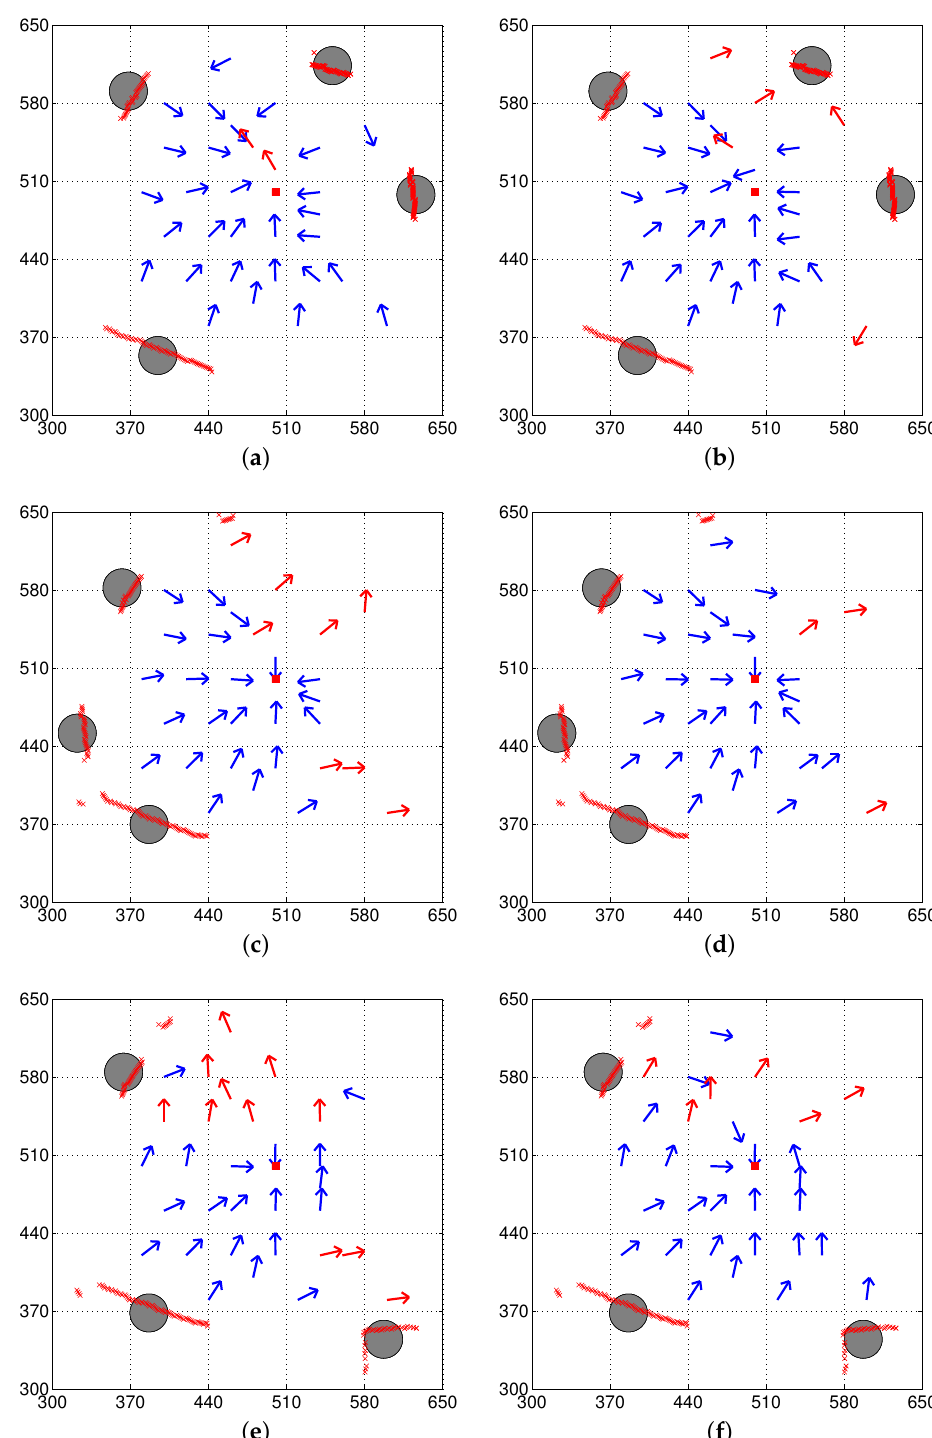
Figure 7. Vector map results with the DELV method but weighted landmark vectors applied for the position estimation (left column: with the reference compass, right column: without the reference compass); ( a , b ) env1; ( c , d ) env2; ( e , f )